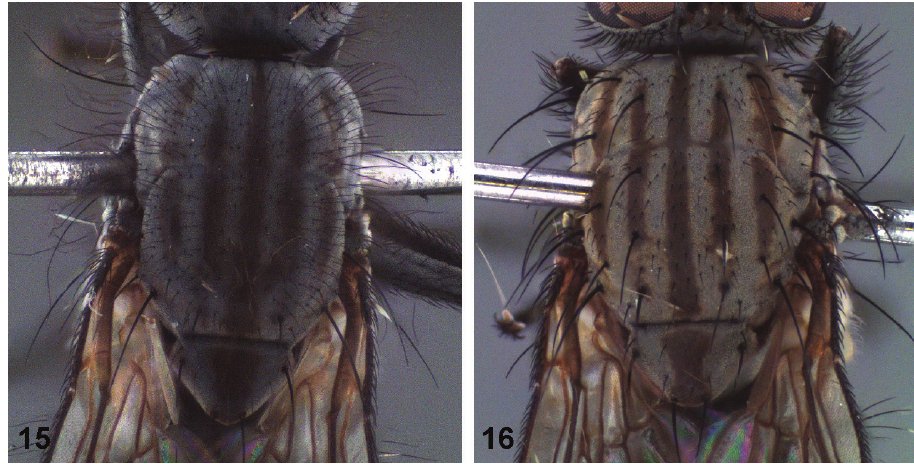
Figures 15, 16. Coenosia flagelliseta sp. nov., scutum, dorsal view 15 male 16 Thorax (Fig. 15): Grey dusted throughout, with five dark brown vittae (lighter brown compared to female), running along the dorsocentral, acrostichal and intra-alar setae; singular acrostichal vitta running to the apex of scutellum. Holotype with 11, paratype with 10 undifferentiated postpronotal setulae, all whip-like in appearance. Prosternum bare. Two notopleural setae of equal length. Two postalar setae, posterior postalar seta 2× length of anterior postalar seta. One pair of supra-alar setae. No strong- ly differentiated intra-alar setae. Dorsocentral setae 1+3. All setae on scutum, with the exception of the apical pair of postsutural dorsocentral setae and the postalar and supra- alar setae, appearing as delicate whip-like setulae, indistinguishable from other setulae on surface of scutum. All setulae on scutum whip-like in appearance (Fig. 15). Scutel- lum: One pair of apical setae, one pair of strongly developed sub-basal setae, ¾ the length of apical setae. One pair of weak basal setulae, no subapical setae and discal setal area restricted to six weak setulae. Subscutellum bare. Two proepisternal setae; two proepimeral setae, lower proepimeral seta downcurved; all proepisternal and proepime- ral setae appearing setulae-like in appearance. Katepisternal setae forming an equilateral triangle (1:1:1), with 8 whip-like setulae inside the triangle; anterior and lower katepis- ternal setae also whip-like in appearance, the lower seta difficult to discern from sur- rounding setulae; posterior seta well-developed, not whip-like. Anepimeron, meron and katepimeron bare; katatergite with fine hyaline hairs, anatergite bare. Katepisternum with 5 whip-like delicate setae on posterior margin and scattered setulae across surface. Wing hyaline and bare, with no conspicuous chaetation or suffusions. Haltere yellow. Legs: Grey, dusted appearance, except for pair of mid coxae with glossy posterior. Joints between femur, tibia and tarsal segments, as well as trochanters amber in colour. Leg chaetation (standard appearance, i.e. not whip-like, unless stated otherwise): Fore femur with posterior surface covered in whip-like setulae, one posterodorsal seta, one posterodorsal row of whip-like setae. Fore tibia with one median posterior seta,